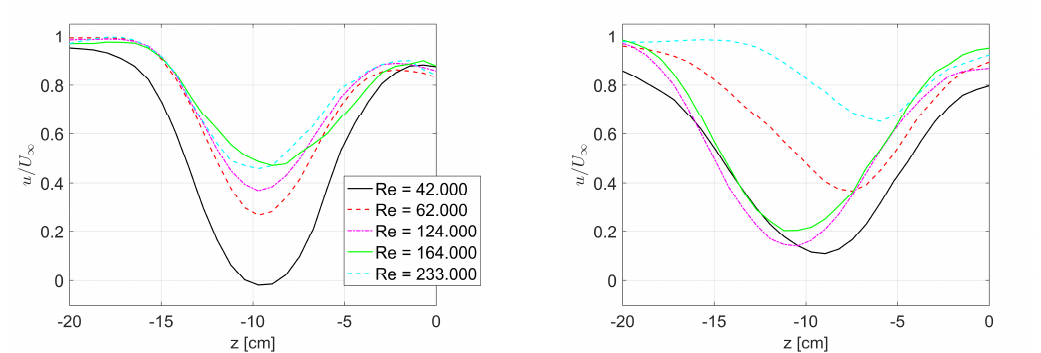
Figure 4. Profiles of non-dimensional time-average streamwise velocity along the z-axis at y = 40 cm ( left ) and y = 80 cm ( right